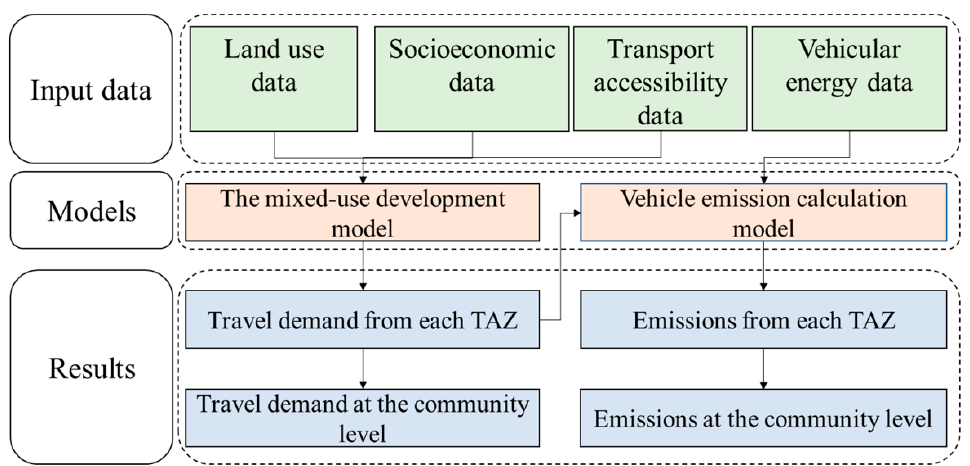
Figure 3. Framework of the research methodology. TAZ, traffic analysis zone.